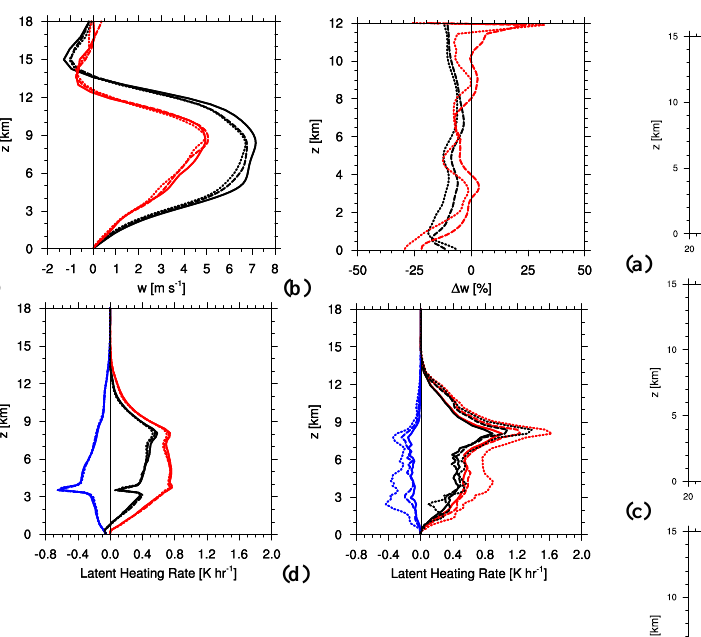
Fig. 13. As in Fig. 7 except for the lowRH simulations.